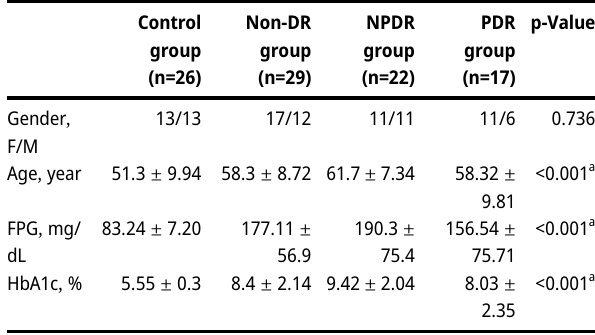
Table  : Baseline characteristics of the study